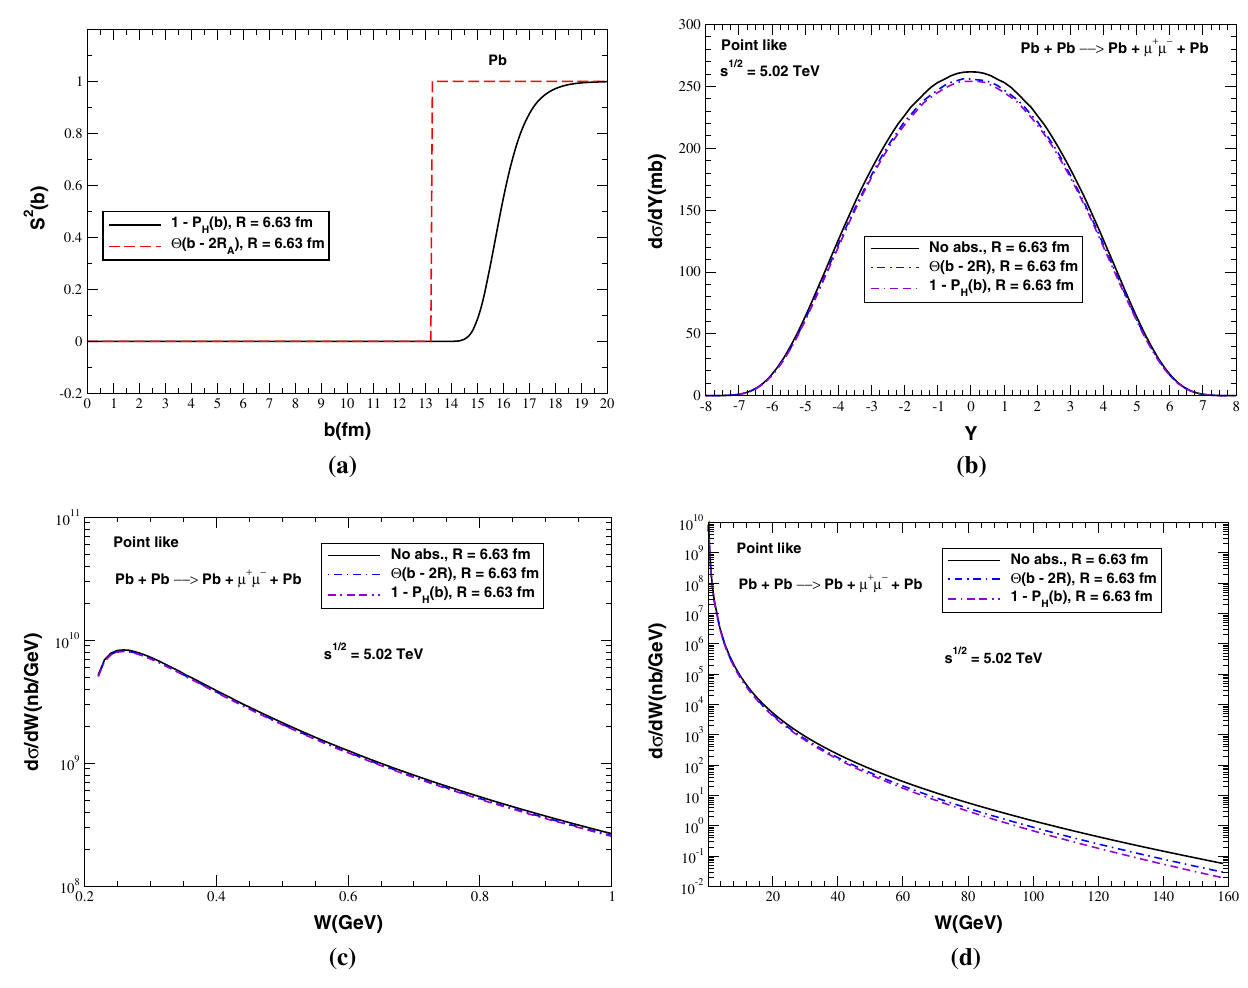
Fig. 2 a Impact parameter dependence of the absorptive factor, b rapidity distribution for the exclusive dimuon production by γγ